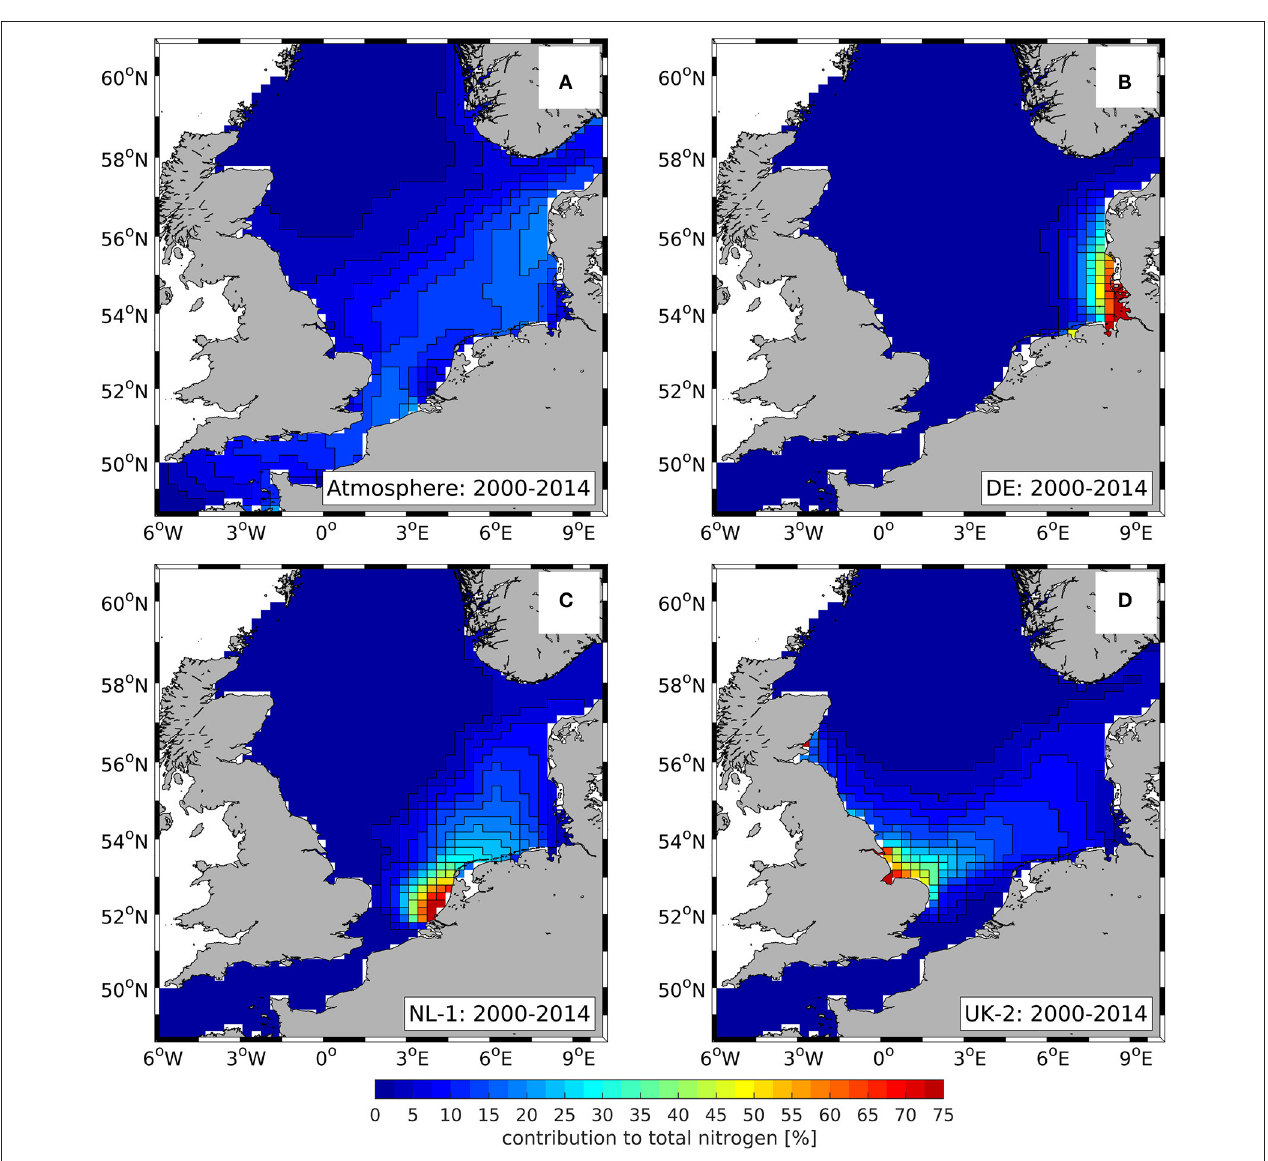
FIGURE 4 | Spatial distribution of 15-year, water column averaged relative contributions of TN from different sources during 2000–2014: (A) atmosphere, (B) German rivers (DE), (C) 1st group of Dutch rivers (NL-1), (D) 2nd group of British rivers (UK-2). Color scale cut at upper limit. Same color scale for all